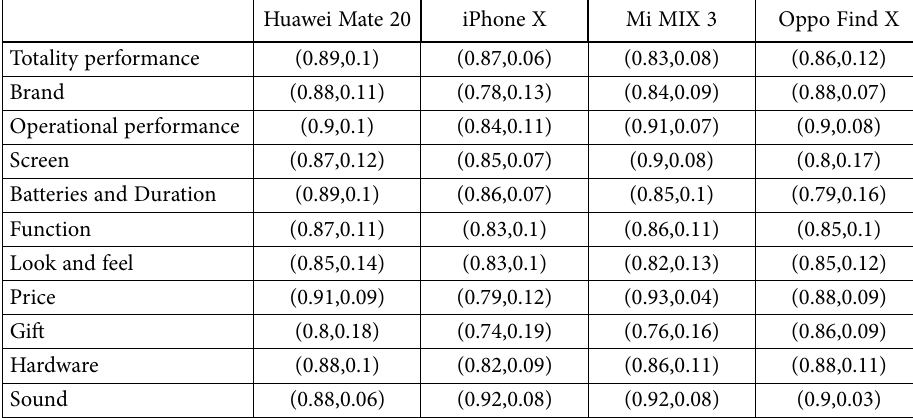
Table 9. The intuitionistic fuzzy decision matrix of jd.com